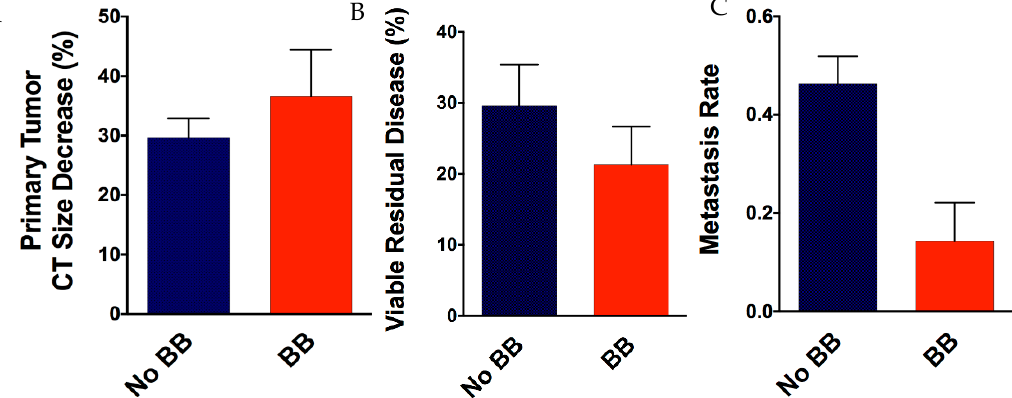
Figure 3. Local primary tumor response and metastases rate. Primary tumor response was assessed by comparing the largest diameter of the lung tumor on baseline computerized tomography (CT) scans with that on CT scans 4–6 weeks after chemoradiation ( A ). Pathological response was determined as percent viable residual tumor at time of surgery ( B ). Metastases rate was determined by the incidence of distant metastatic disease ( C ). BB, beta-blocker.